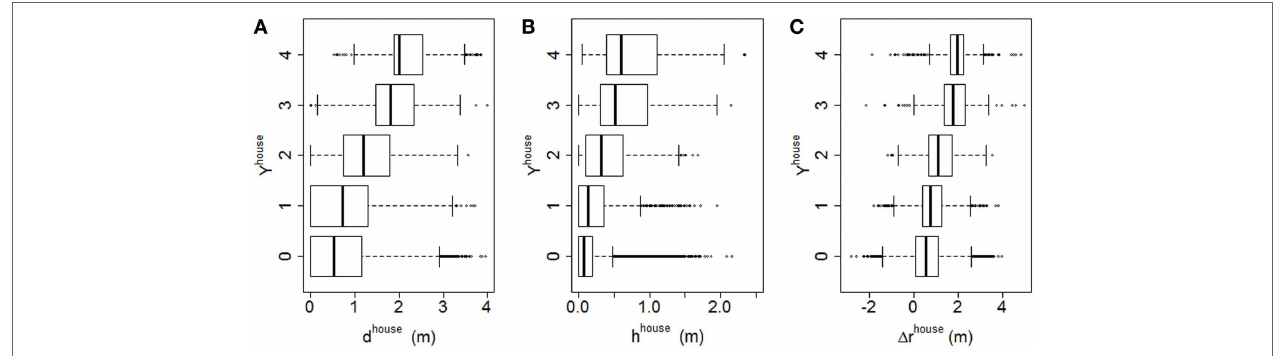
FIGURE 7 | Box plots relating quartiles of (A) maximum inundation, (B) significant wave height, and (C) relative inundation to damage states from Federal Emergency Management Agency aerial survey (0—no damage, 1—affected, 2—minor damage, 3—major damage, and 4—destroyed).